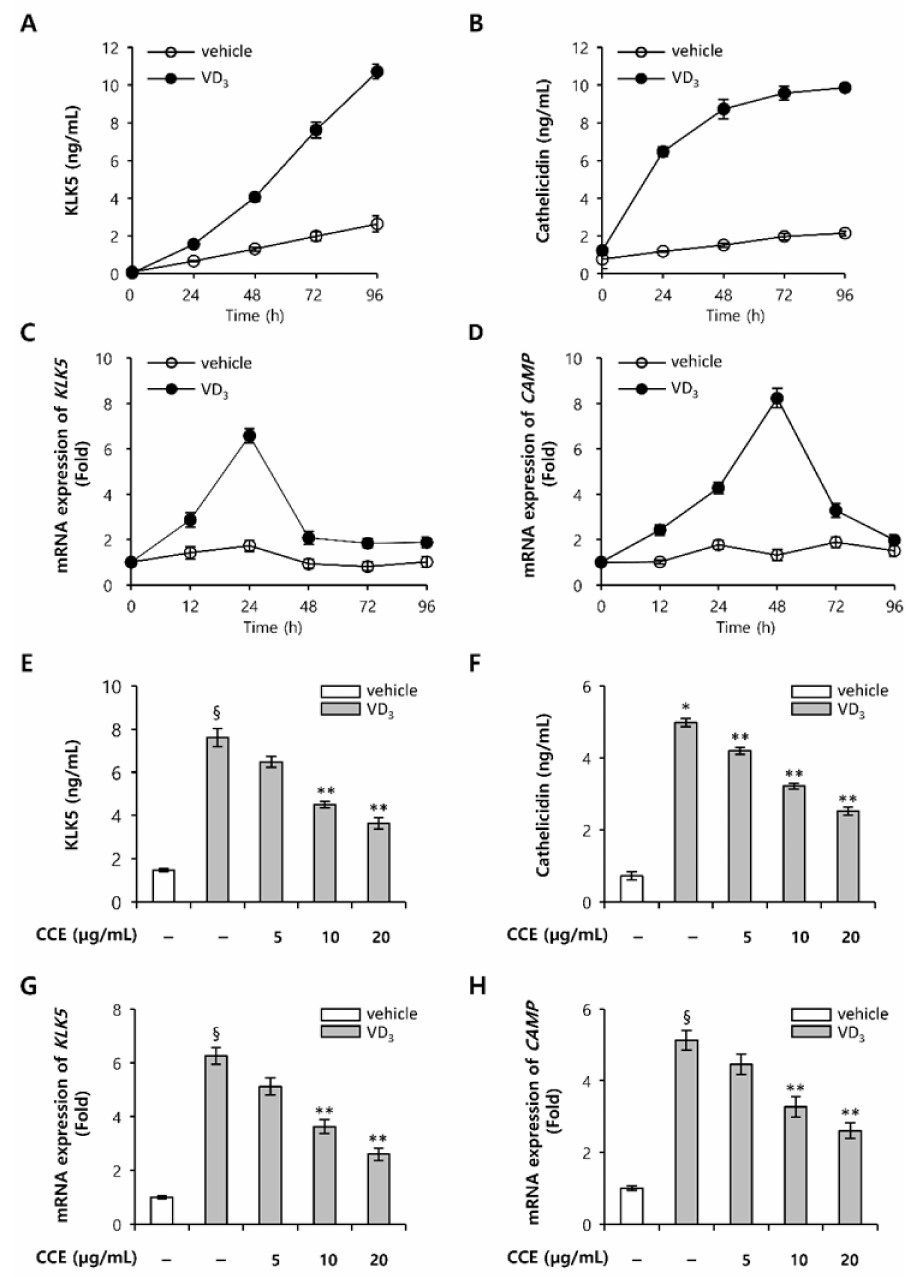
Figure 2. CCE inhibits KLK5 and cathelicidin expression in human epidermal keratinocyte induced by VD 3 . HEKn (passage 3) at 90% confluence was stimulated with VD 3 for 12, 24, 48, 72, or 96 h. ( A , B ) The expression of KLK5 and cathelicidin protein was measured by ELISA, while ( C , D ) KLK5 and cathelicidin mRNA were measured by quantitative real-time PCR. HEKn (passage 3) at 90% confluence was pre-incubated with 5, 10, or 20 µ g / mL CCE for 2 h, and subsequently treated with 200 nM VD 3 for 96 h. ( E , F ) The expression of KLK5 and cathelicidin protein was measured by ELISA. ( G , H ) KLK5 and cathelicidin mRNA were measured by quantitative real-time PCR. The results are mean ± standard deviation (SD) ( n = 3). * p < 0.001 vs. vehicle control; § p < 0.01 vs. vehicle control; ** p < 0.01 vs. vehicle control; DMSO vehicle control